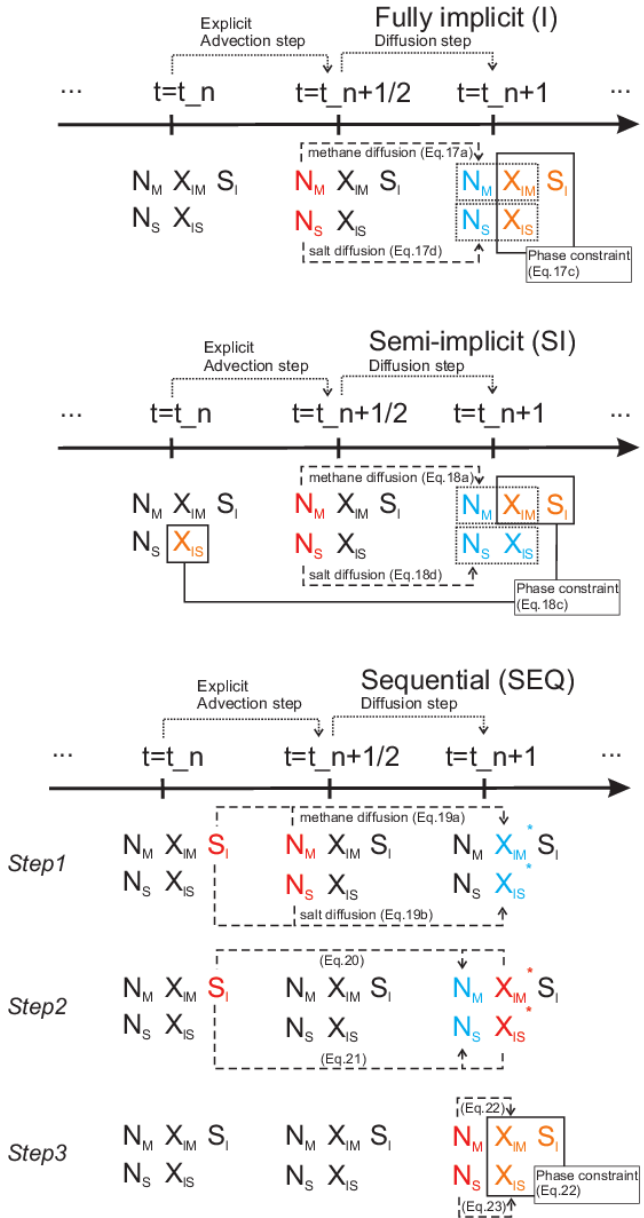
Figure 1. Illustration of time stepping